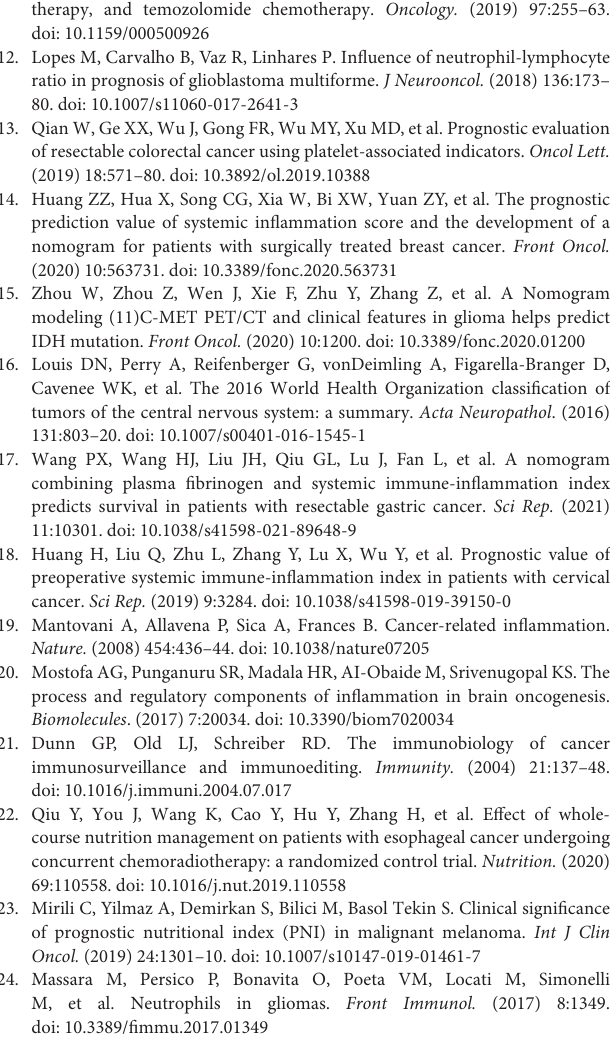
Supplementary Figure 1 | Forest plot of multivariate COX